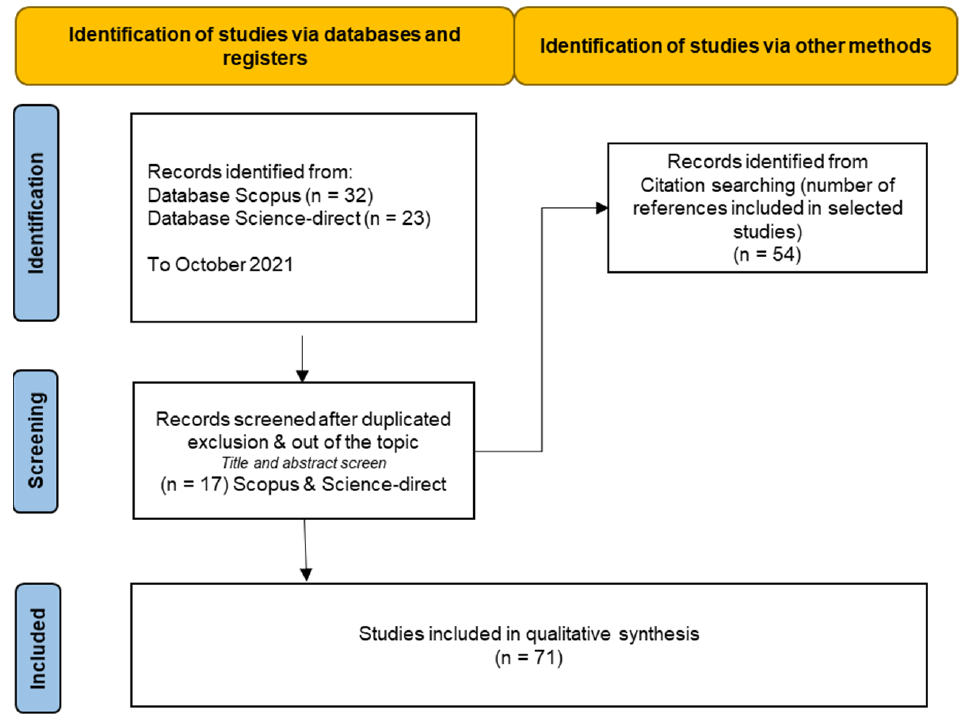
Figure 3. Flow diagram describing the study selection process of the scientific literature.